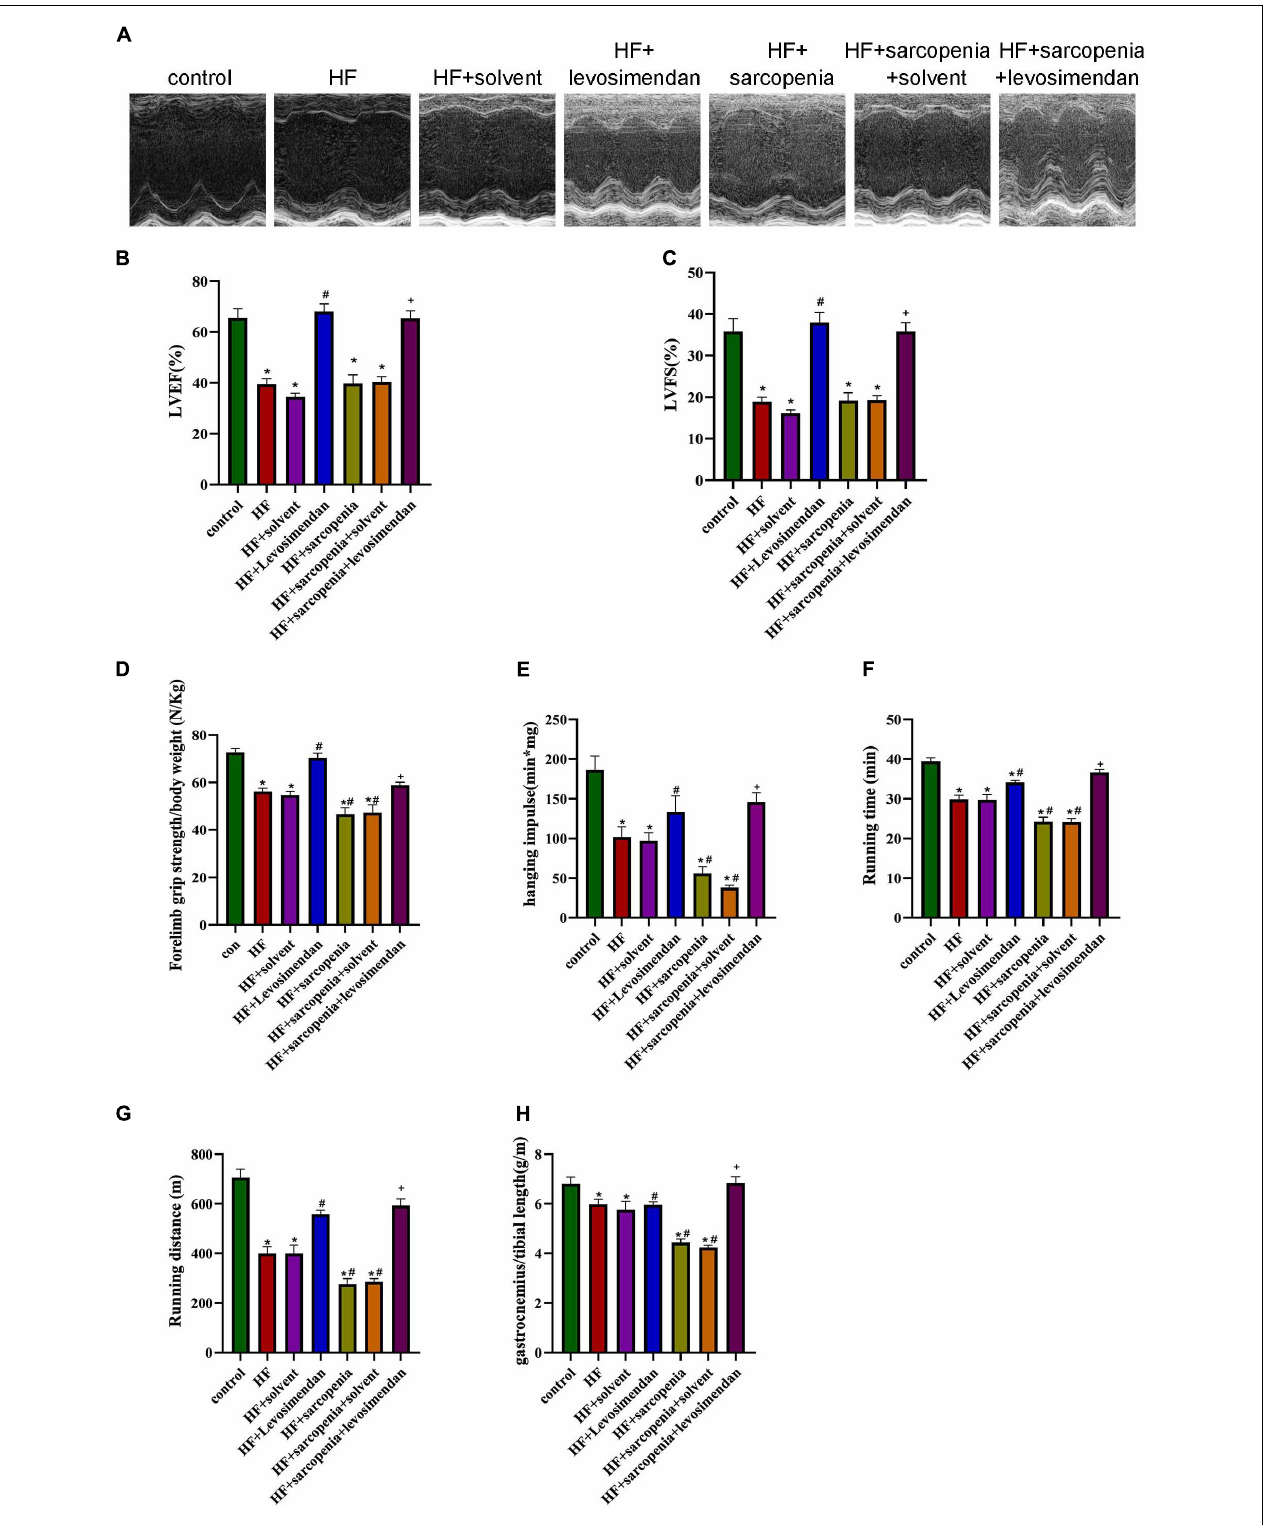
FIGURE 2 | Levosimendan improves cardiac function and exercise capacity in mice with heart failure and sarcopenia (A) echocardiography. (B) LVEF (%). (C) LVFS (%). (D) Forelimb grip strength/body weight (N/Kg). (E) Hanging impulse (min*mg). (F) Running time (min). (G) Running distance(m). (H) Ratio of gastrocnemius weight to tibial length (g/m). N = 5–12. * P < 0.05 vs. control, # P < 0.05 vs. HF, + P < 0.05 vs. HF + sarcopenia. Bar = 40 µ m.